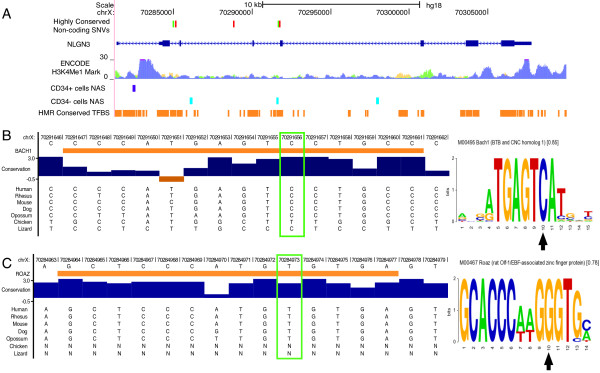
Genomic location and evolutionary conservation of noncoding variants. (A) The genomic position of highly conserved noncoding single nucleotide variants (SNVs) in NLGN3 overlap with H3K4Me1 enhancer- and promotor-associated marks in various cell types (orange = H1 embryonic stem cells, green = human mammary epithelial cells (HMEC) and purple = human leukemia cells (K562)); CD34 cells nuclease accessibility sites (NAS) (purple = sites on CD34+ cells and blue = sites of CD34- cells); and human-mouse-rat (HMR) conserved transcription factor binding sites (TFBS) (orange blocks). The two variants that fall within HMR TFBS are highlighted in green. (B) Variant (chrX:70291656; also outlined in a green box) is located within a highly conserved 15-bp Bach1 TFBS (z-score 2.86, P < 0.003;). The sequence logo for the consensus Bach1 TFBS is shown to the right. The black arrow shows the position of the the variant (chrX:70291656) within this highly conserved binding motif. (C) Variant (chrX:70284973; outlined in a green box) is located within a highly conserved 14-bp Roaz TFBS (z-score 2.86, P < 0.003). The sequence logo for the consensus Roaz TFBS is shown to the right. The black arrow shows the position of the the variant (chrX:70284973) within this highly conserved binding motif.